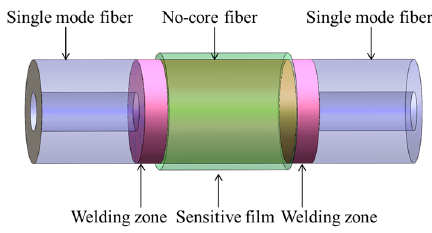
Figure 2. Specific structure of SNS sensing structure.